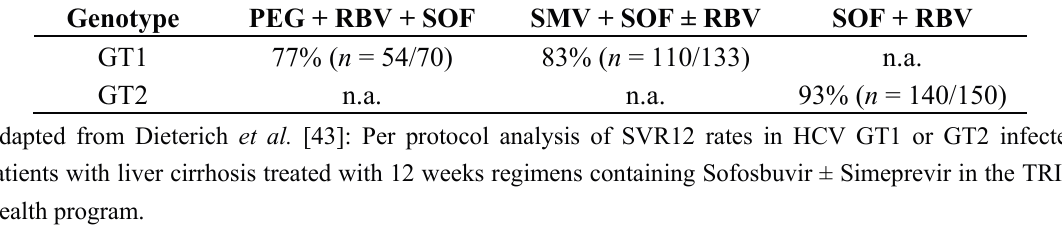
Table 5. Per protocol analysis of SVR12 rates in the TRIO Health Program.